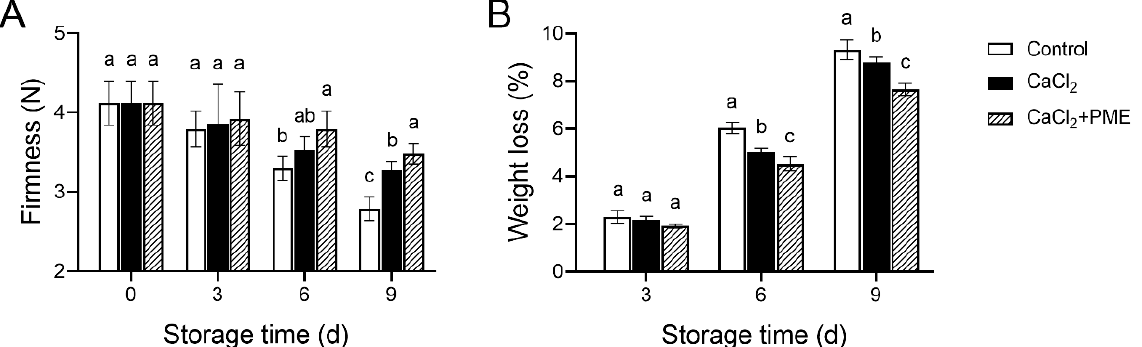
Figure 1. Effects of different treatments on firmness ( A ) and weight loss ( B ) of raspberry fruit. Data presented were based on three replicates. Vertical bars represent standard deviations of the means. Different lowercase letters indicate the significant differences among the treatments ( p < 0.05).